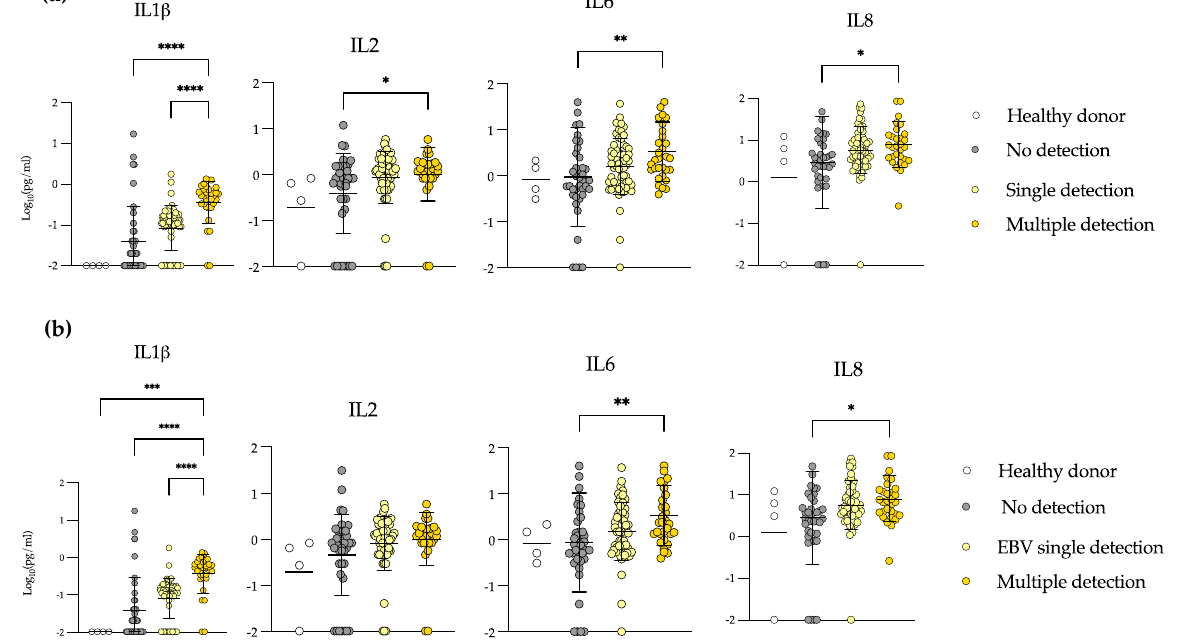
Figure 3. Samples in which multiple viruses were detected show high systemic levels of inflamma- tory cytokines. Plasma levels of IL-1 β , IL-2, IL-6 and IL-8 in healthy donors, no viral detection, single detection ((a): any virus,(b): EBV) and multiple detection samples in patients with allogeneic trans- plant. Mann–Whitney test. * = p < 0.05, ** = p < 0.01, *** = p < 0.001, **** = p < 0.0001.